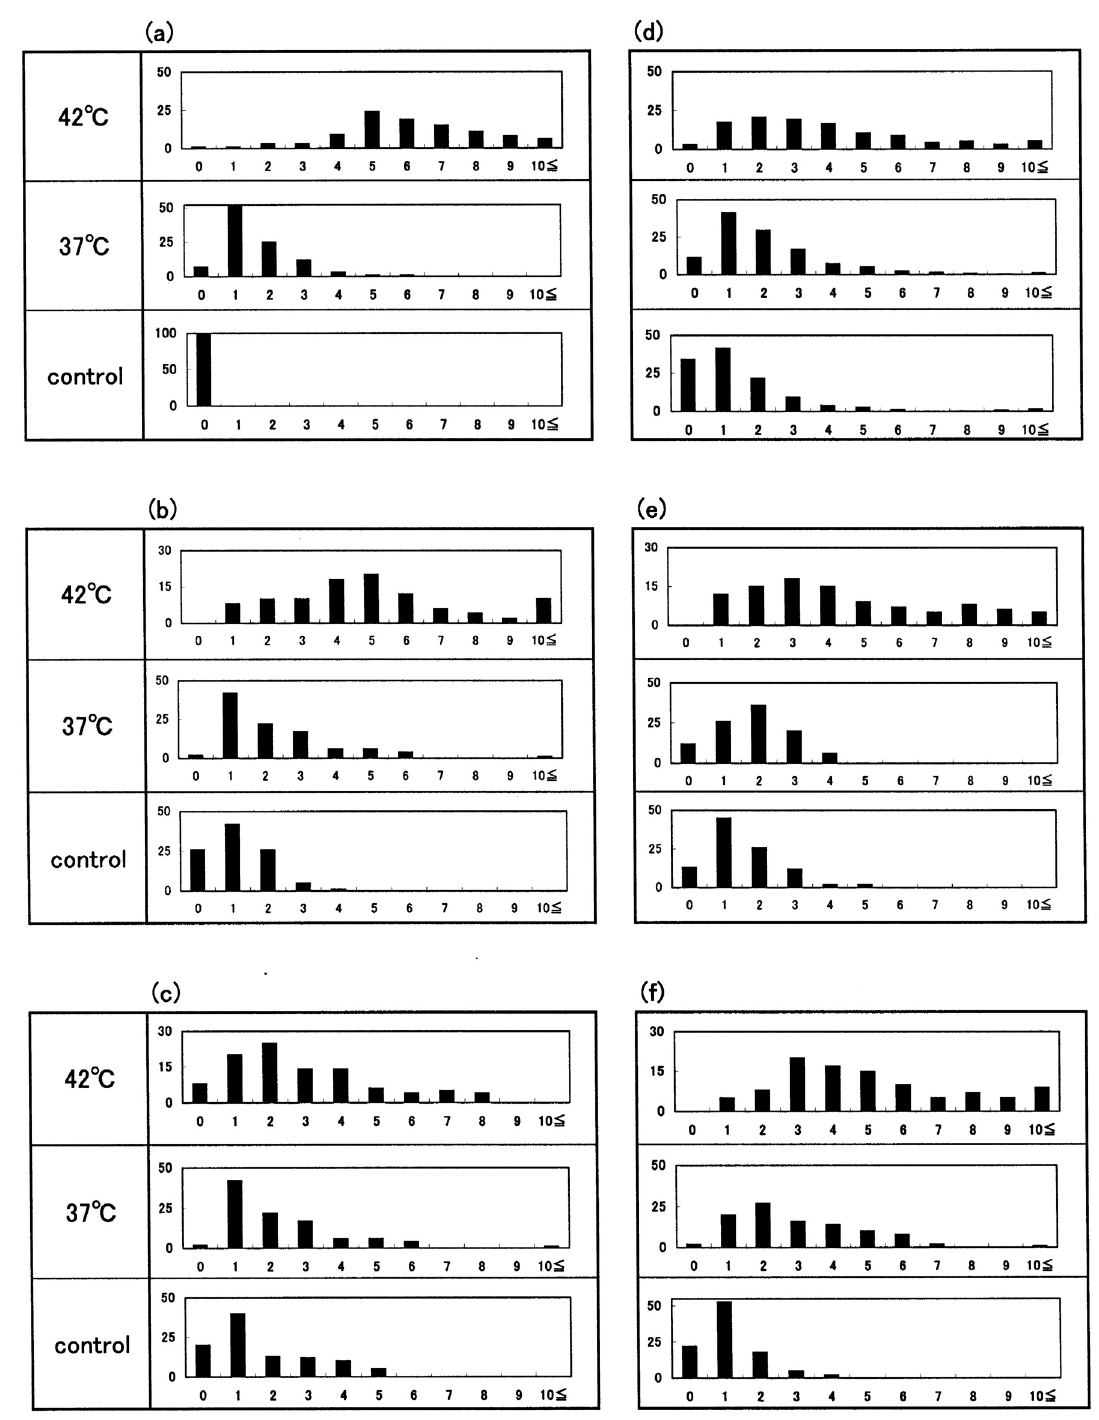
Figure 15. Histograms representing Heinz bodies detected in blood samples after mild heating at >37 °C, redrawn from Sugawara et al. [23,24]. The histograms for 37 °C and 42 °C are displayed using a temperature-untreated sample as a reference. One-hundred red cells were chosen, and the number of Heinz bodies contained in each red cell counted. ( a ) was constructed from the microscopic views shown in Figure 14, whereas ( b – f ) represent the results from another five healthy